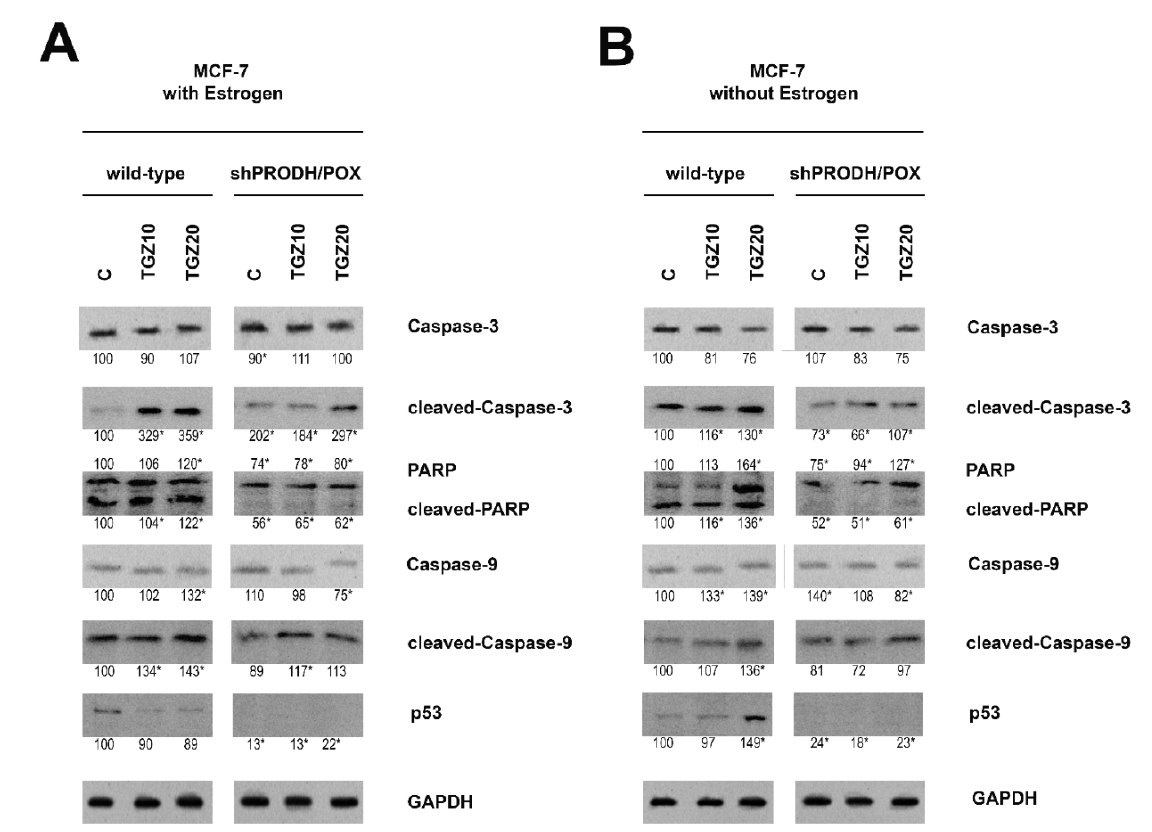
Figure 3. Western blot for cleaved caspase-3, PARP, caspase-9 and p53 in wild type and PRODH/POX-silenced (shPRODH/POX) MCF-7 cells treated with troglitazone (TGZ) for 24 h in the presence ( A ) and absence ( B ) of estradiol. GAPDH expression was used as a loading control. Representative blot images were shown (the mean value of densitometric analysis of protein bands presented below each blot; * p < 0.01). Supplementary Materials contain statistical analysis of the evaluated proteins (Supplementary Material, Supplementary Figures S8–S13).